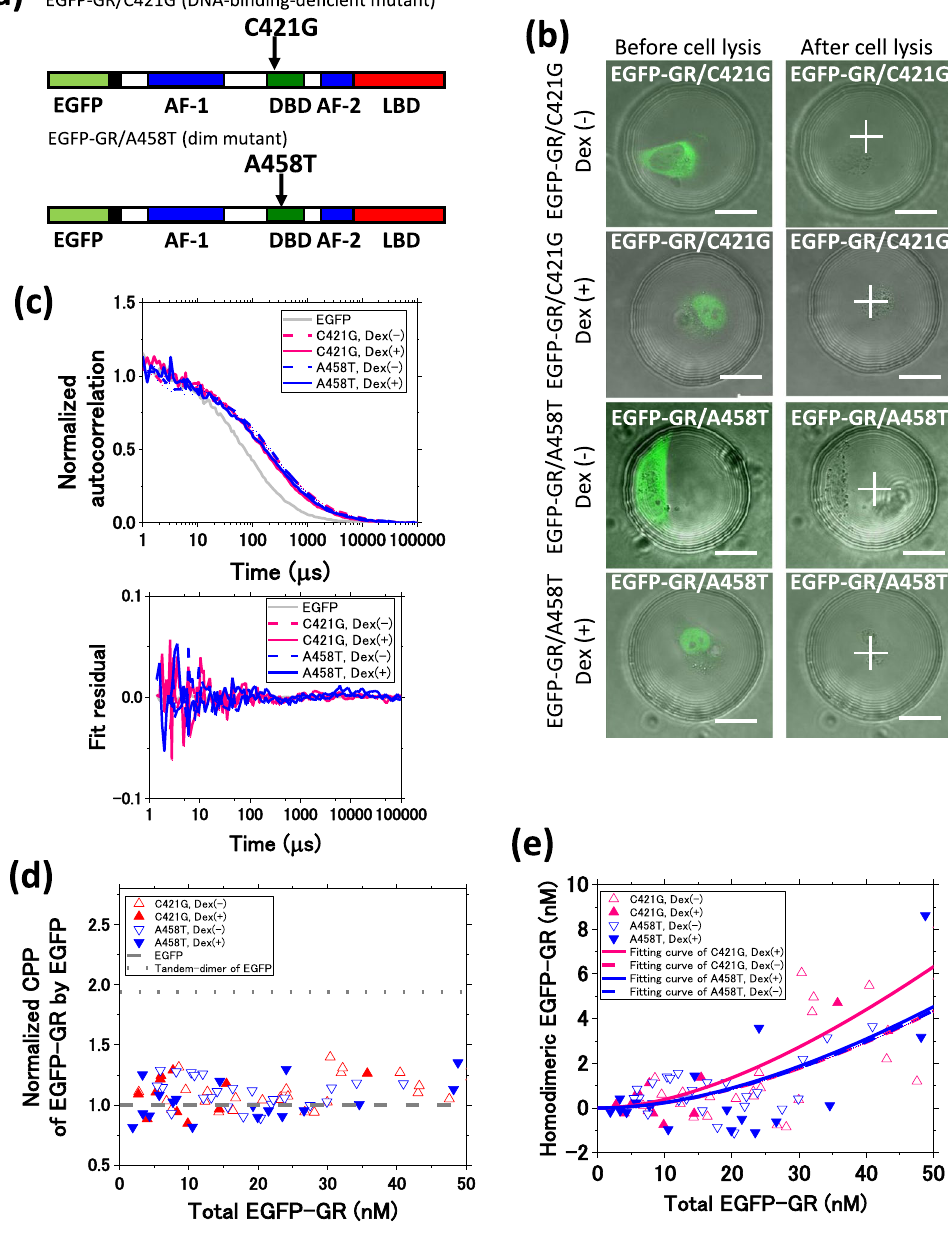
Figure 2. Homodimerization of glucocorticoid receptor mutants. ( a ) A schematic diagram of the EGFP-fused C421G mutant (DNA binding-deficient) and the A458T mutant (dim mutant for transcriptional activity). ( b ) Typical fluorescent images of a single cell expressing EGFP-GR/C421G or EGFP-GR/A458T, in the absence and presence of Dex, before and after cell lysis. White crosses indicate the position of FCS measurements. (Scale bar: 20 μ m). ( c ) Typical normalized autocorrelation functions and fit residuals of EGFP-GR/C421G and EGFP-GR/A458T in the absence and presence of Dex. Grey solid line: EGFP, red dashed line: EGFP-GR/C421G in the absence of Dex, red solid line: EGFP-GR/C421G in the presence of Dex, blue dashed line: EGFP-GR/A458T in the absence of Dex, blue solid line: EGFP-GR/A458T in the presence of Dex. ( d ) The normalized CPP of EGFP-GR mutants in the 0–50 nM concentration range. The full concentration range is shown in Fig. S6C and D. Red open triangle: GR/C421G in the absence of Dex, red solid triangle: GR/C421G in the presence of Dex, blue open triangle: GR/A458T in the absence of Dex, blue solid triangle: GR/A458T in the presence of Dex, grey dashed line: EGFP. ( e ) K d,homo determination by non-linear least squares fitting of equation (16) (Supplemental Methods) in the 0–50 nM range. Red open triangle: GR/C421G in the absence of Dex (N = 25); red solid triangle: GR/C421G in the presence of Dex (N = 11); blue open triangle: GR/A458T in the absence of Dex (N = 25); blue solid triangle: GR/A458T in the presence of Dex (N = 19); red dashed and solid lines: GR/C421G in the absence of Dex ( K d,homo : 400 ± 100 nM, Χ 2 = 0.5) and presence of Dex ( K d,homo : 220 ± 30 nM, Χ 2 = 2.7); blue dashed and solid lines: GR/A458T in the absence of Dex ( K d,homo : 390 ± 80 nM, ± 120 nM, Χ 2 = 2.6). The K ± SE. The full Χ 2 = 0.7) and presence of Dex ( K d,homo : 370 d,homo values are averages concentration range is shown in Fig. S6E. Χ 2 represents the chi-square value per degree of